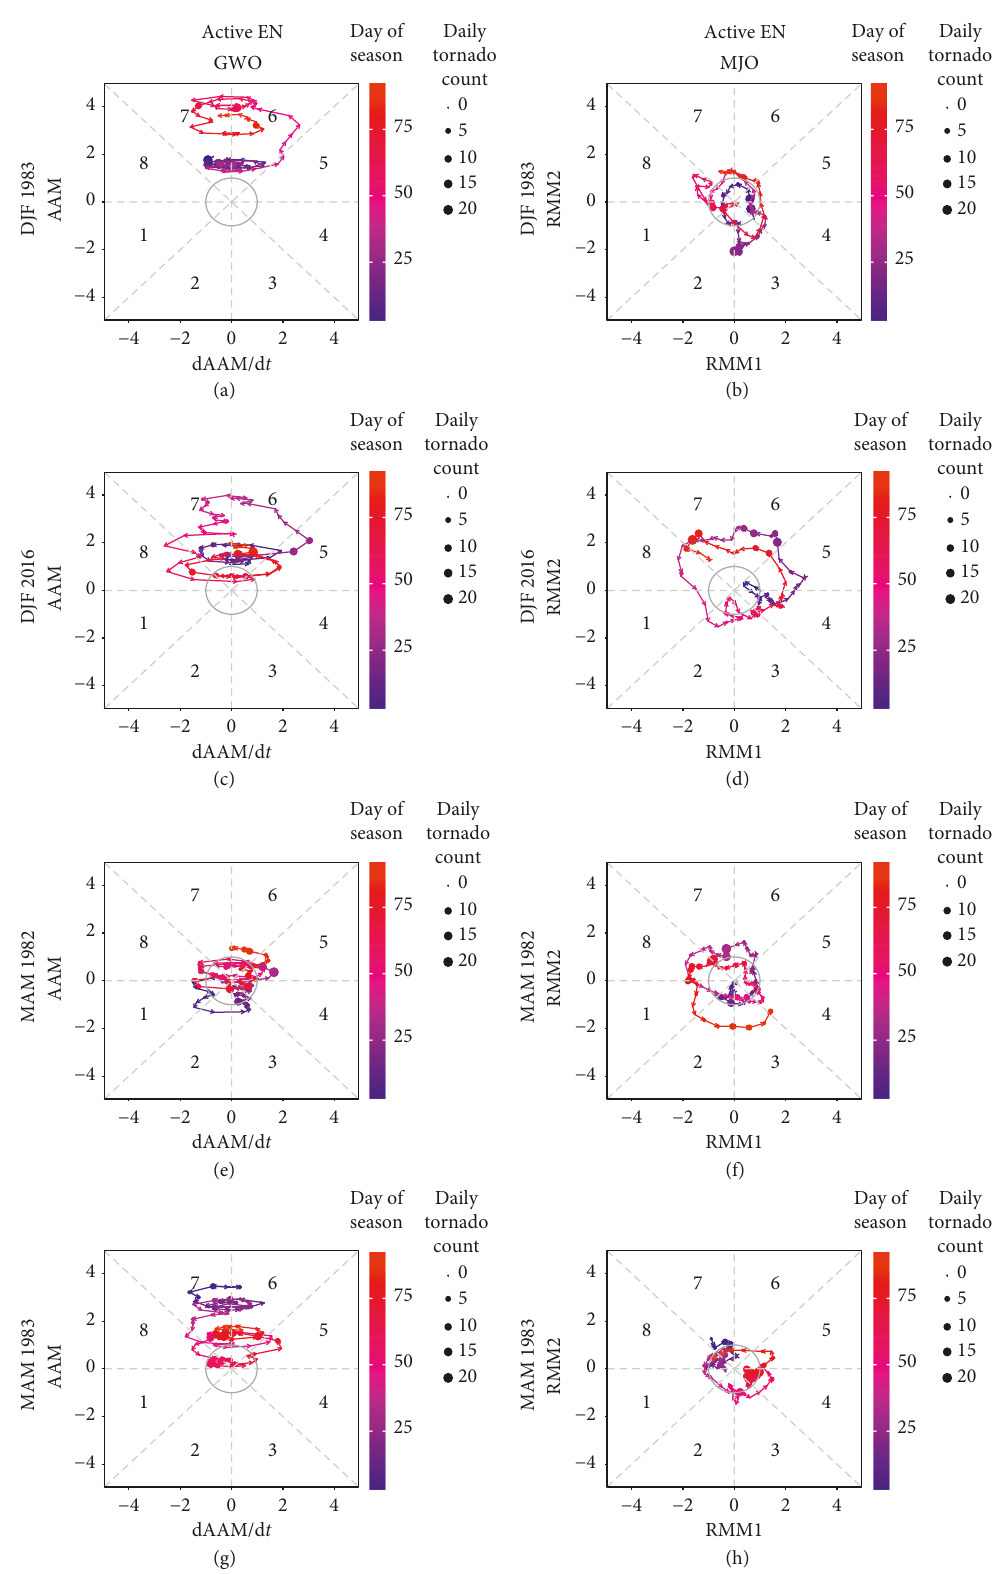
Figure 3: Phase space diagrams for the GWO (a, c, e, and g) and MJO (b, d, f, and h) during the two EN DJFs and MAMs with the most